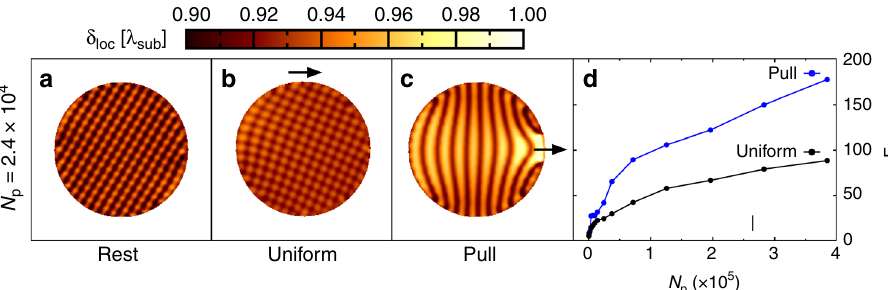
Fig. 4 Strain distribution and static friction of a uniformly driven versus edge-driven 2D FK model. a – c Colored maps showing the local average distance δ loc between nearest-neighbor particles in a 2D FK model of an incommensurate (overdense) circular island subjected to a periodic square-symmetry substrate potential 82 , https://doi.org/10.1103/PhysRevMaterials.2.046001. Expressed in units of the underlying periodicity, values of δ loc = 1 (white color) indicate local commensuration to the substrate. The three panels compare the local strain distribution in the island at rest ( a ), and under the action of an external force, below the static friction threshold, applying a uniform driving ( b ) or pulling at the leading edge of the cluster ( c ). d Static friction force as a function of the contact area, i.e., the number of particles in the island, evaluated for uniform driving (black) and pulling at the leading edge. Due to the particle overdensity of the island with respect to the substrate minima arrangement, the edge pulling procedure favors the formation of locally strained commensurate regions, enhancing static